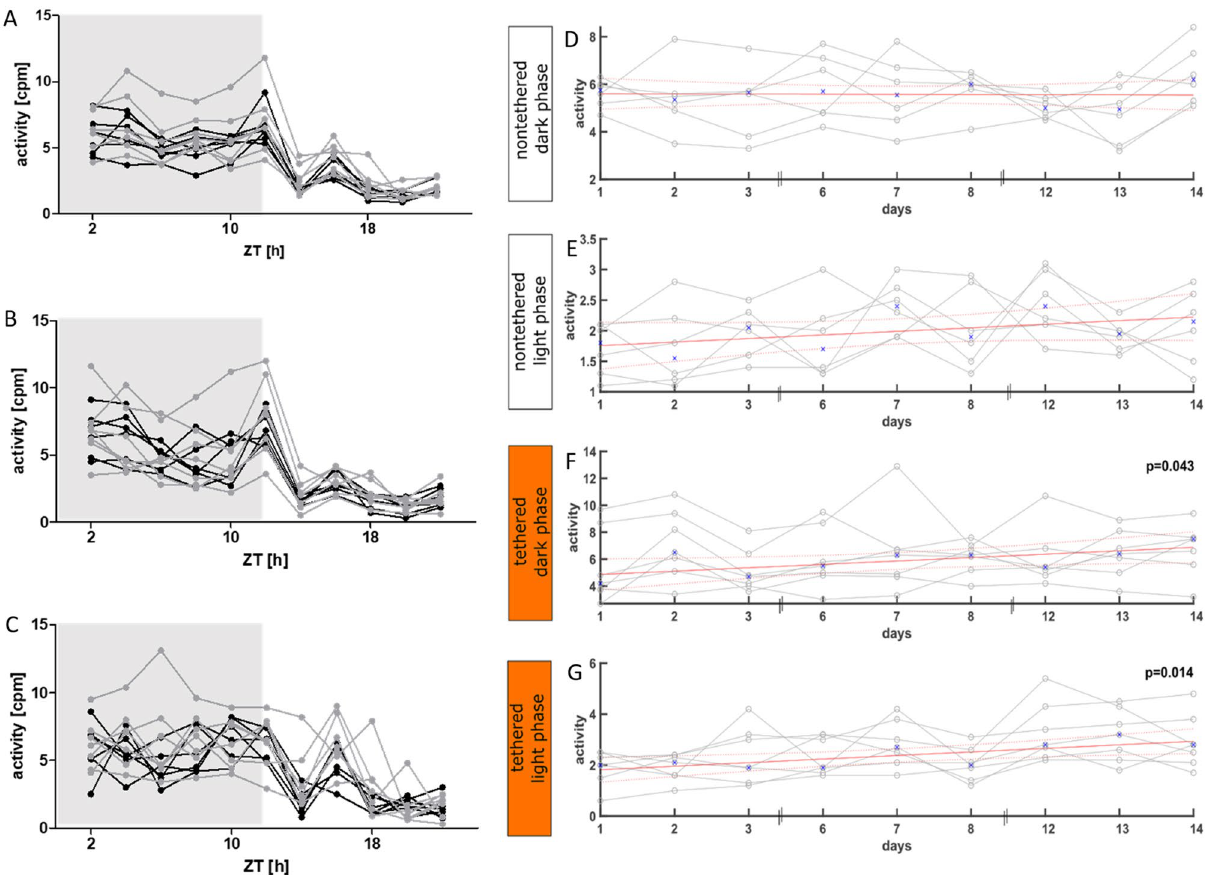
Figure 8. Activity analysis of the nontethered (n = 6) and tethered (n = 7) animals. ( A – C ) Activity counts of the nontethered (black) and tethered (gray) animals for nonoverlapping 2 h observation episodes throughout the 22 h. Lights were turned on after 12 h. Gray = dark phase, white = light phase. The x-axis represents Zeitgeber time (ZT). cpm = counts per minute. ( A ) Averaged values for all 9 days of the experimental observation period. The analysis detected no significant difference between the nontethered (black) and tethered (gray) animals at any time point. ( B ) Averaged values for the first 3 days (early) of the experimental observation period. The analysis detected no significant difference between the nontethered (black) and tethered (gray) animals at any time point. ( C ) Averaged values for the last 3 days (late) of the experimental observation period. The analysis detected no significant difference between the nontethered (black) and tethered (gray) animals at any time point. Data are plotted individually for each animal. Differences between the groups were tested using a two- way ANOVA with factors “nontethered/tethered” and “hours”, followed by a post-hoc Bonferroni multiple comparison test. ( D – G ) Linear regression model of activity counts of the nontethered and tethered animals throughout the experimental observation phase. For each animal, the average per day pooled for the dark phase and light phase was calculated. The x-axis represents the days. ( D , E ) Linear regression model of activity counts of the nontethered animals for the dark phase ( D ) and light phase ( E ). The activity level was not significantly different over the time course of the observation period. ( F , G ) Linear regression model of activity counts of the tethered animals for the dark phase ( F ) and light phase ( G ). A significant increase in activity counts was analyzed for the dark phase (p = 0.043) and the light phase (p = 0.014). Data are plotted individually for each